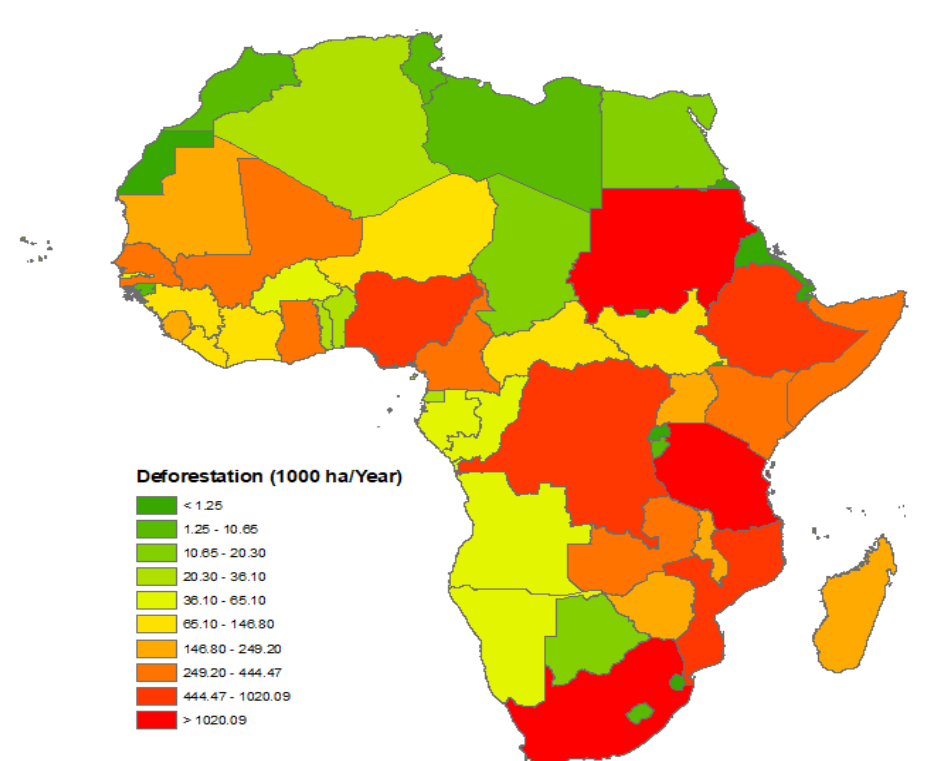
Figure 3. Deforestation (forest area change) in African countries from 1990 to 2020 in 1000 ha/year. Sources: Authors’ compilation, analysis and mapping from FAO, FAO- STAT, and FRA databases.